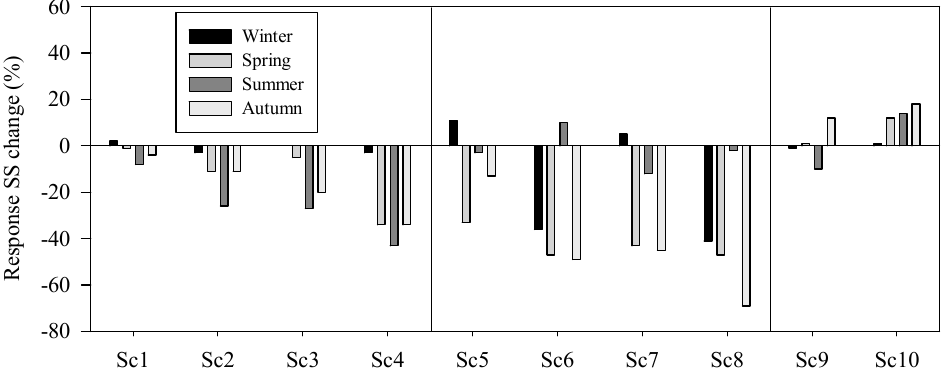
Figure 4. Seasonal response of suspended sediment (SS) yield to changes in temperature (Sc1, Sc2, Sc3 and Sc4), rainfall (Sc5, Sc6, Sc7 and Sc8) and CO 2 concentration (Sc9, Sc10) based on the scenarios defined in Table 1. Sc1: T + mean 2031–2060 °C; Sc2: T + max 2031–2060 °C; Sc3: T + mean 2069–2098 °C; Sc4: T + max 2069–2098 °C; Sc5: P–mean 2031%–2060%; Sc6: P–max 2031%–2060%; Sc7: P–mean 2069%–2098%; Sc8: P–max 2069%–2098%; Sc9: 1.5 × CO 2 ; Sc10: 2 × CO 2 .